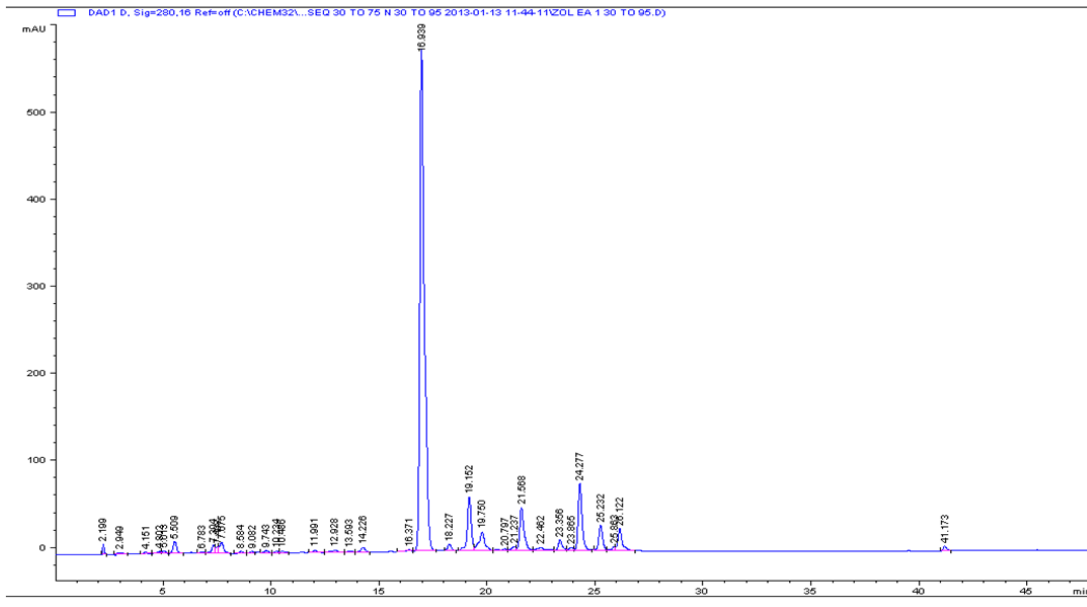
Figure 1. Analytical HPLC chromatogram for ZE3 sub-fraction.